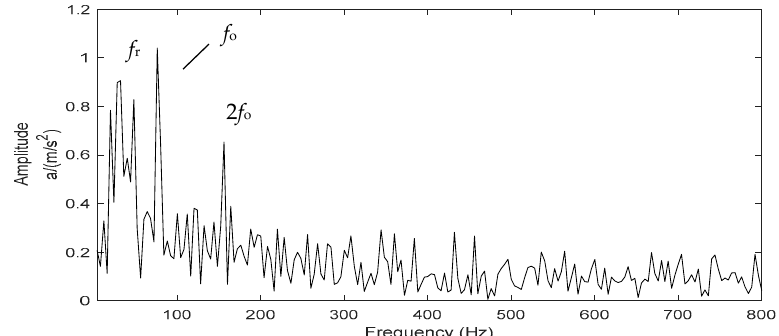
Figure 14. The Hilbert envelope spectrum of the MOC 1 ( t ) obtained by the RS-LOD.